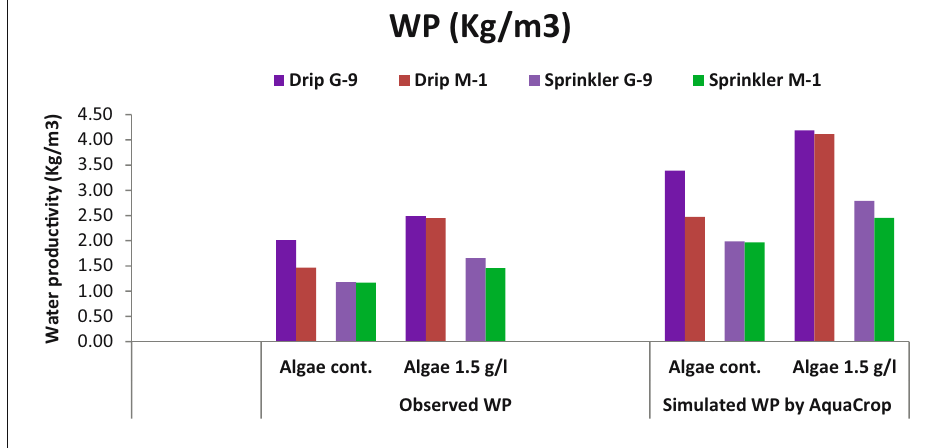
Figure 5: The e ff ect of irrigation systems, wheat varieties and algae on observed and simulated water